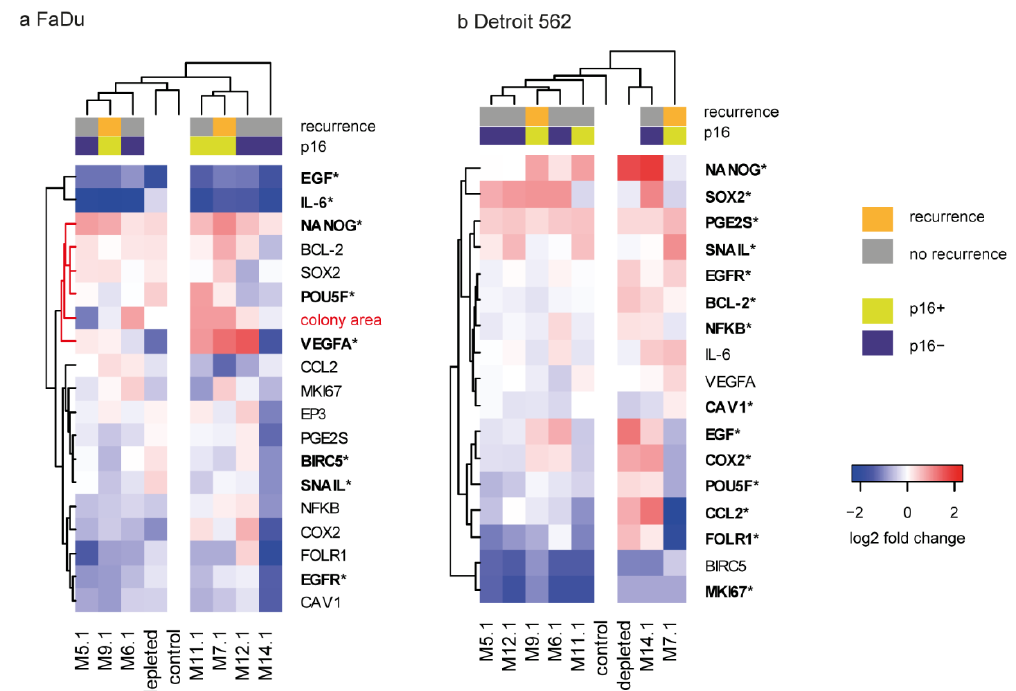
Figure 3. The effect of CAF-derived media (CMCAF) on gene expression in FaDu and Detroit cells. ( a ) Gene expression pattern of FaDu cells relative to non-co-cultured FaDu cells in log2 fold change, together with the log2-transformed colony area. Red cluster branch indicates genes clustered with colony area, see Figure 4d for correlations. ( b ) Gene expression pattern of Detroit 562 cell line cocultured with patient-derived CAFs; the analogue of ( a ). Genes highlighted in bold with an asterisk indicate significant change compared to the 24 h-depleted medium. Columns represent patients; rows represent genes. Gene expression levels are indicated by color: red denotes upregulation; blue denotes downregulation.